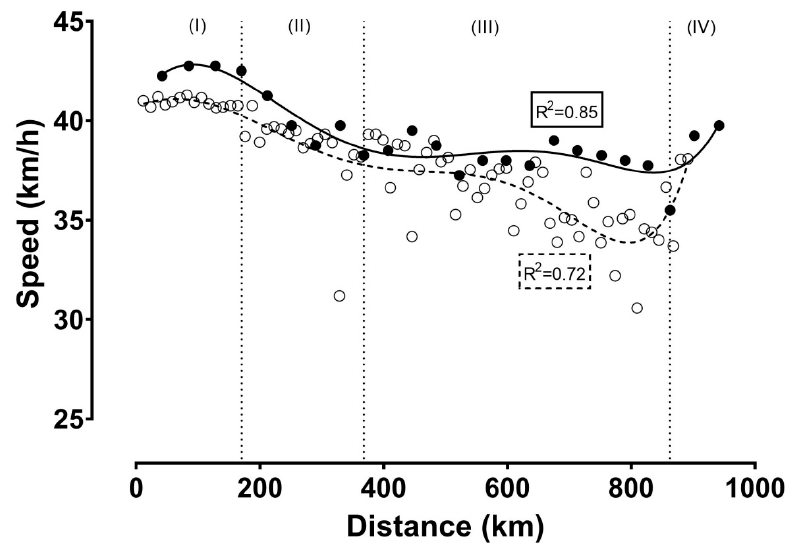
Figure 1. Cycling speed (km/h) during the record attempt. Latin numbers (I, II, III, IV) denote the phases of the race, which are separated by vertical dashed lines. The present record attempt (track cycling) is presented by , whereas the previous attempt (road cycling) is presented by . R 2 estimates the goodness of fit.